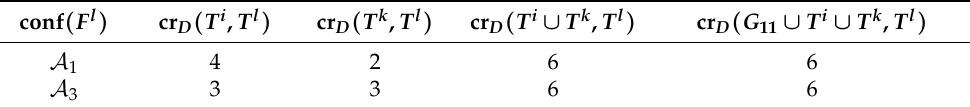
Table 1. All possibilities of the subgraph F l for T l ∈ R D , l (cid:54) = i with cr D ( T i , T k ) = 2 and T k ∈ S D